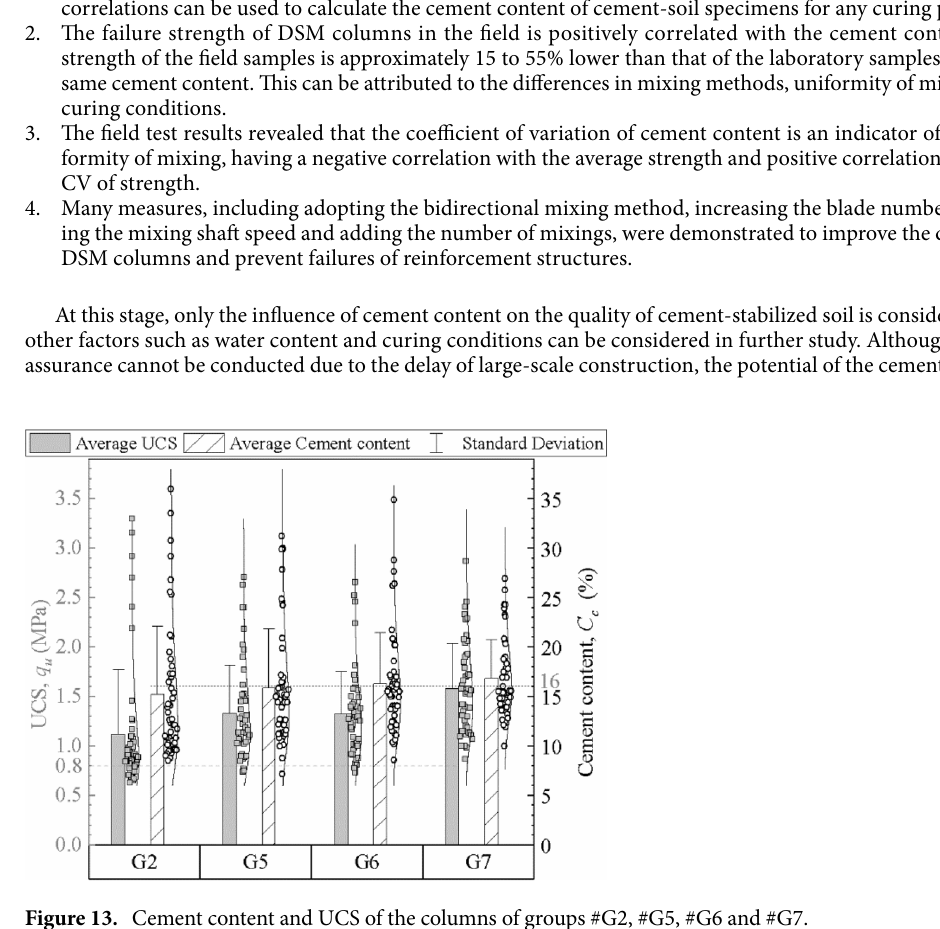
Figure 13. Cement content and UCS of the columns of groups #G2, #G5, #G6 and